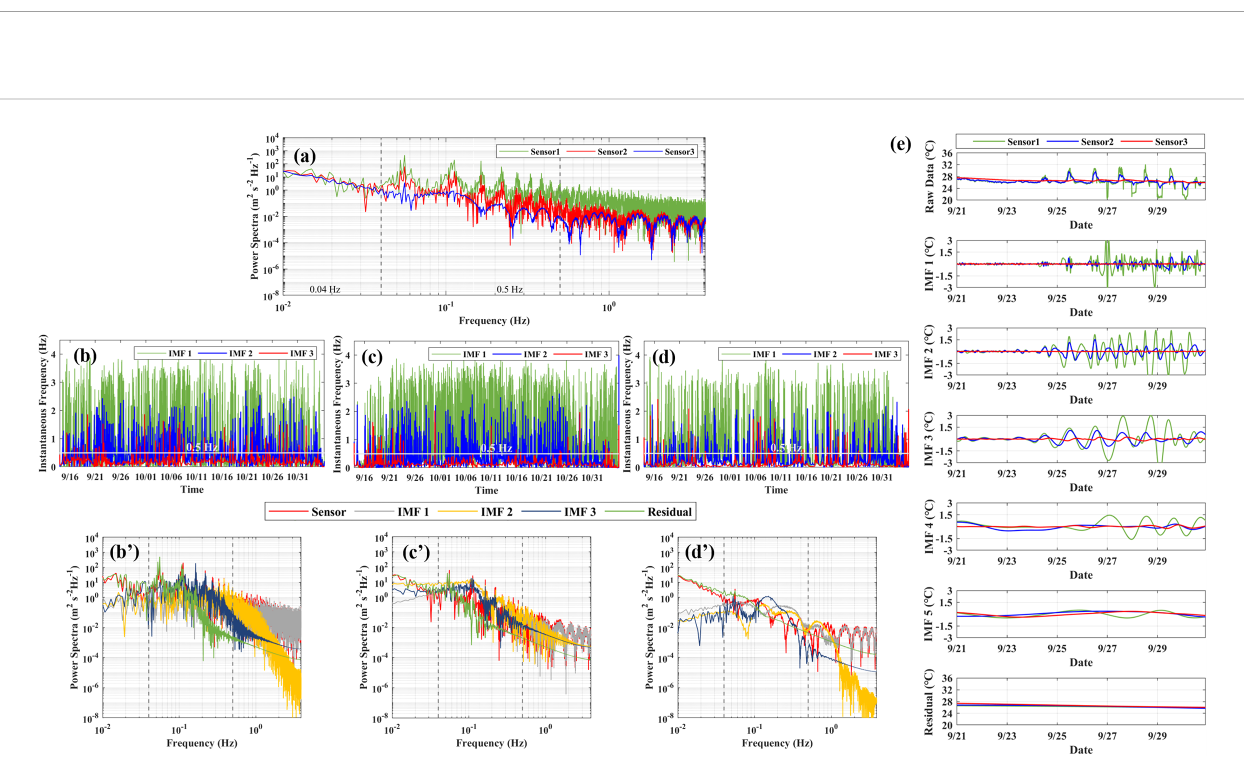
FIGURE 13 (A) The power spectra of the tidal fl at temperature: sensor 1 (green), sensor 2 (red), and sensor 3 (blue). (B – D) Instantaneous frequency time series of IMF 1 – 3 of the tidal fl at temperature: (B) sensor 1, (C) sensor 2, and (D) sensor 3. (B ’– D ’ ) The power spectra of the tidal fl at temperature (red) and its decomposed IMFs and residual: (B ’ ) sensor 1, (C ’ ) sensor 2, and (D ’ ) sensor 3. (E) Time series of EMD decomposition results of tidal fl at temperature. From top to bottom: raw data, IMF 1 − 5, and residual (from September 21 to October 1,